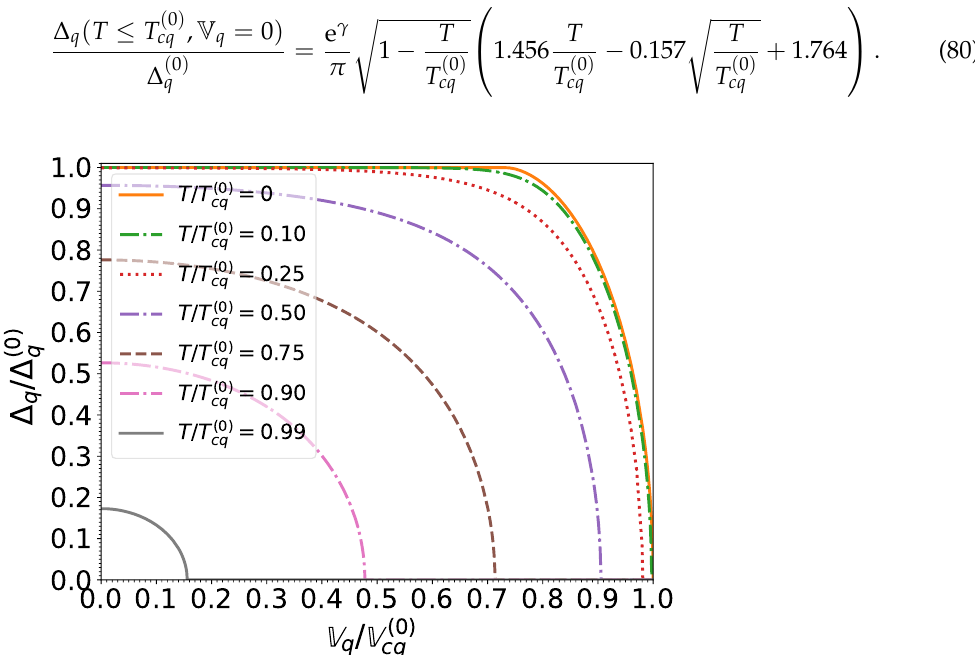
( 0 ) cq for different normalized